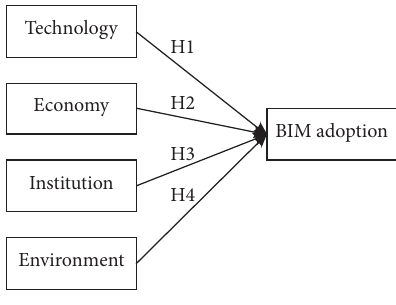
Figure 1: The theoretical model.